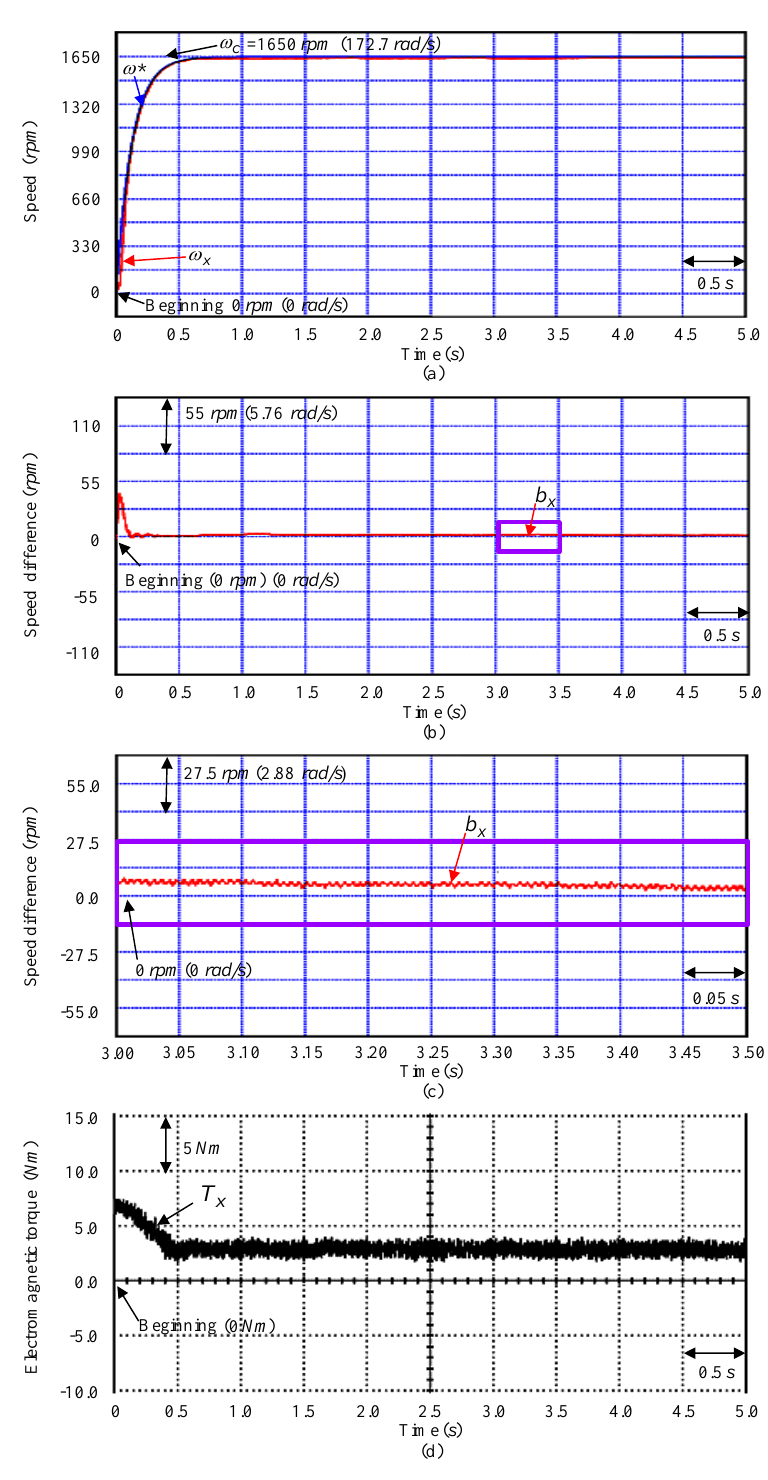
Figure 6. Tested instances with experimental results obtained by using the controller CD1 for the SSCCRIM impelled continuously variable transmission assembled system at the examination Y1 instance: ( a ) speed response, ( b ) speed difference response, ( c ) enlargement of speed difference response, ( d ) electromagnetic torque response .